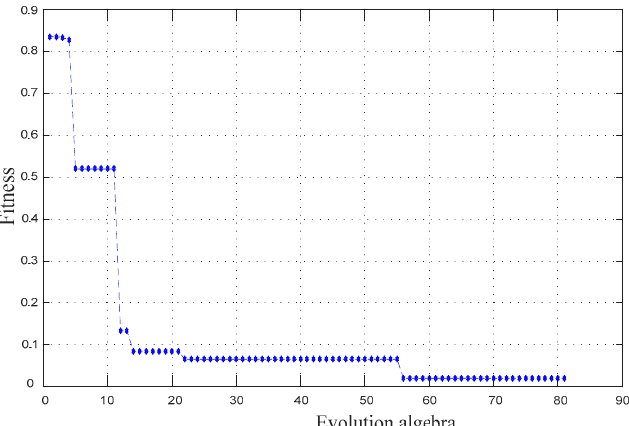
Figure 7. The process of fitness value decline.